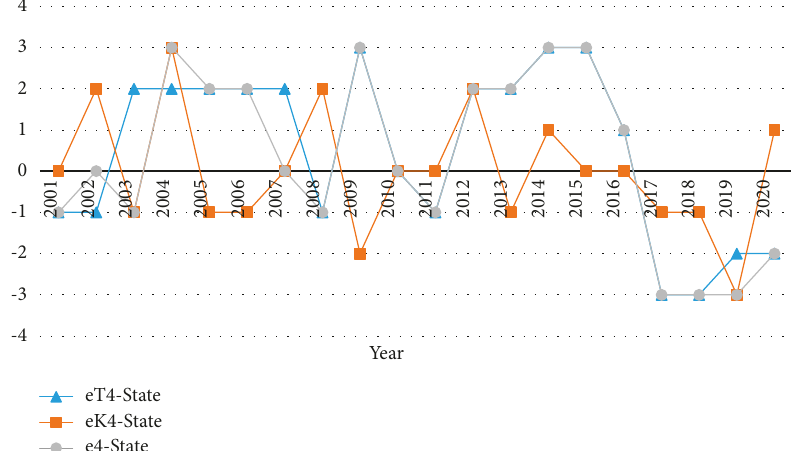
Figure 18: Decoupling of energy efficiency, energy structure, and carbon emission of the nonferrous metal sector from 2001 to 2020.